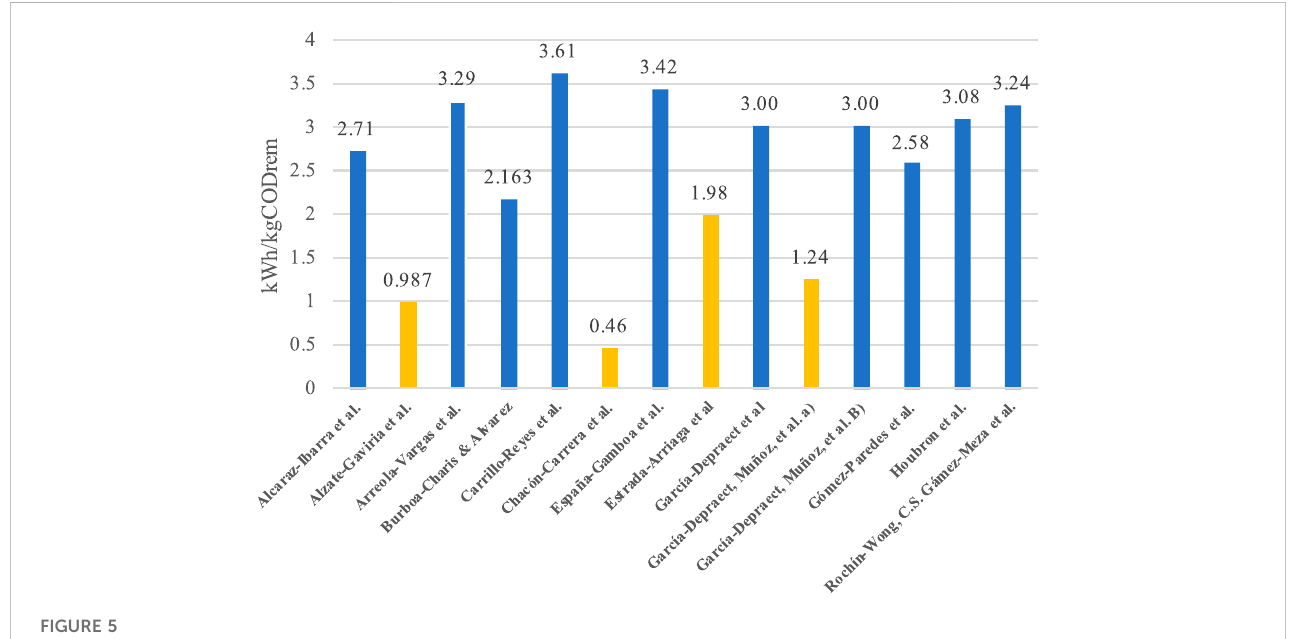
FIGURE 5 Energy obtained from the CODremoved from wastewater in this review.